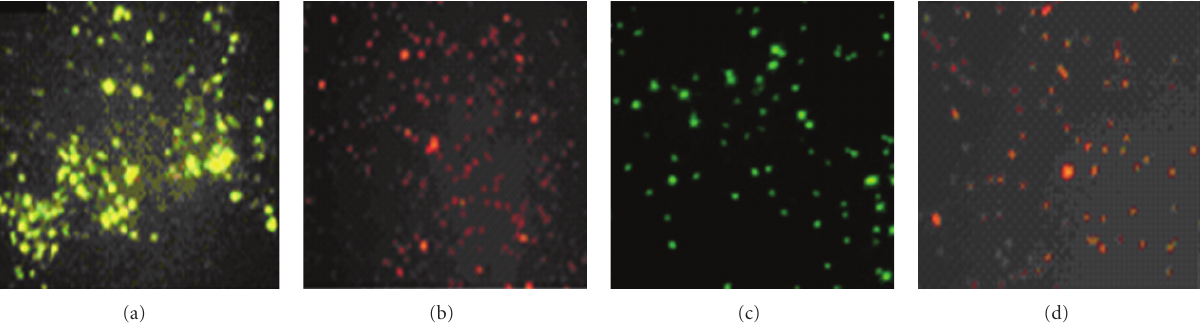
Figure 3: Cell surface expression of VP4. Nisin-induced pNZ8112-VP4/NZ9000 showed specific green fluorescence when stained either with FITC-conjugated goat anti-mouse IgG containing 1% Evans blue dye (a) or FITC-conjugated goat anti-mouse IgG without Evans blue dye (c). No green fluorescence was observed, but red pellets can be seen in induced pNZ8112-VP4/NZ9000 (d) stained with 1% Evans blue and in pNZ8112-/NZ9000 stained with FITC-conjugated goat anti-mouse IgG containing 1% Evans (b).